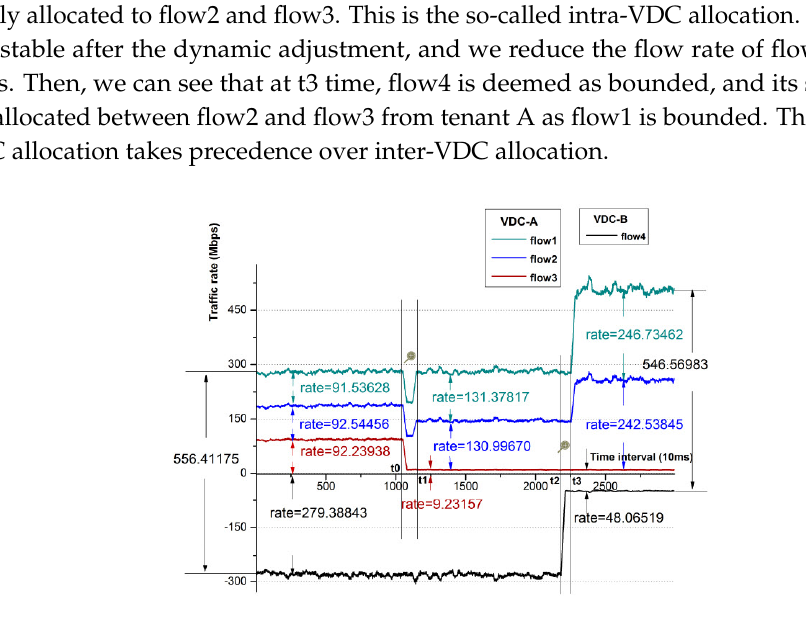
Figure 11. The variation of the flow rates.